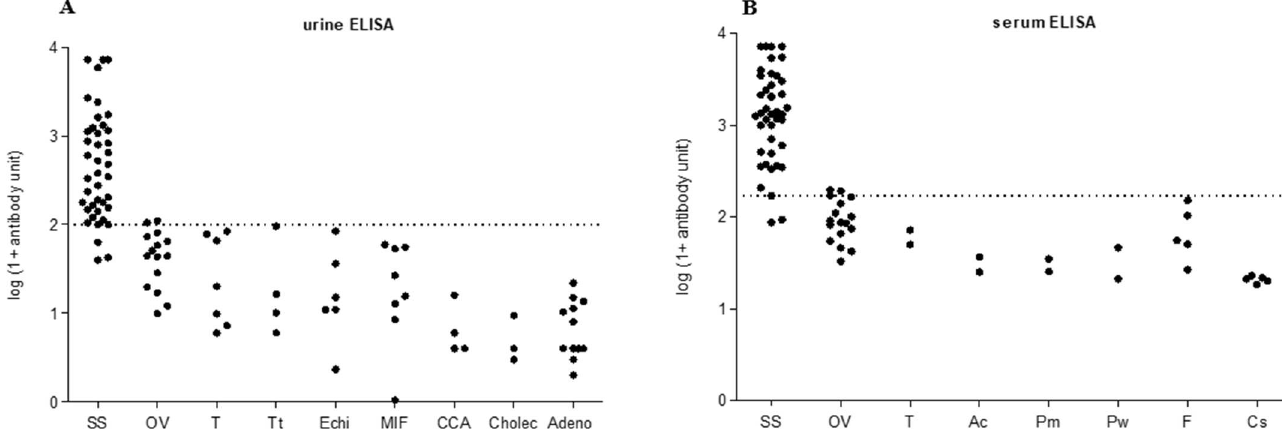
Fig 3. Tests for cross reactivity with other parasites and disease for strongyloidiasis. Tests for cross reactivity of the urine ELISA (A) and serum ELISA (B) for strongyloidiasis. (SS, S . stercoralis ; OV; O . viverrini ; T, Taenia sp.; Tt, T . trichuira ; Echi, Echinostomes; MIF, minute intestinal flukes; Ac, A . cantonensis ; Pw, P . westernmani ; Pm, P . miyazakii ; F, Fasciola spp.; Cs, C . sinensis ; CCA, cholangiocarcinoma, Cholec, cholecystitis; and Adeno, adenocarcinoma).